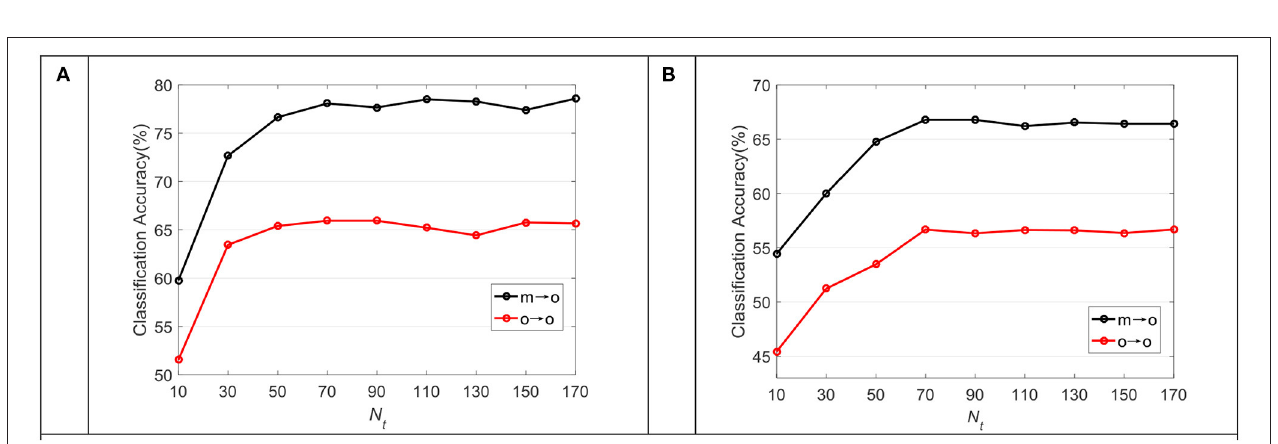
FIGURE 7 | The average classification accuracy of the TDDPL approach under varying N t in the TD on (A) SEED dataset, (B) SEED IV dataset.